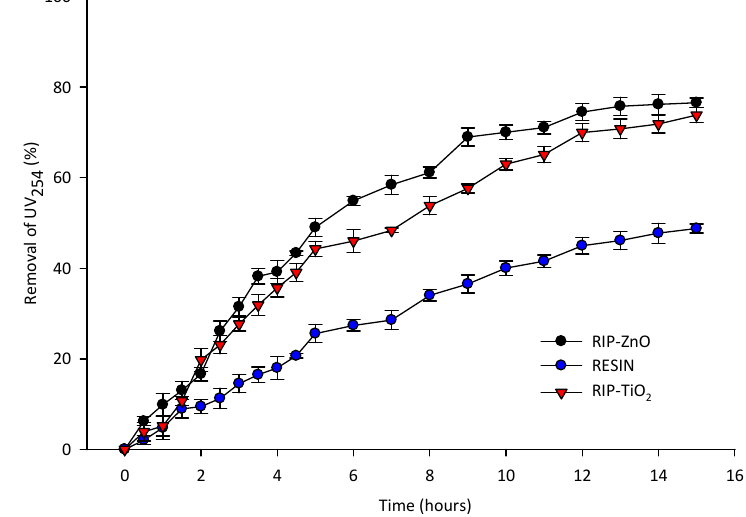
Fig. 2: Performance of resin, RIP‐TiO 2 , and RIP‐ZnO in removing UV 254 in tofu wastewater